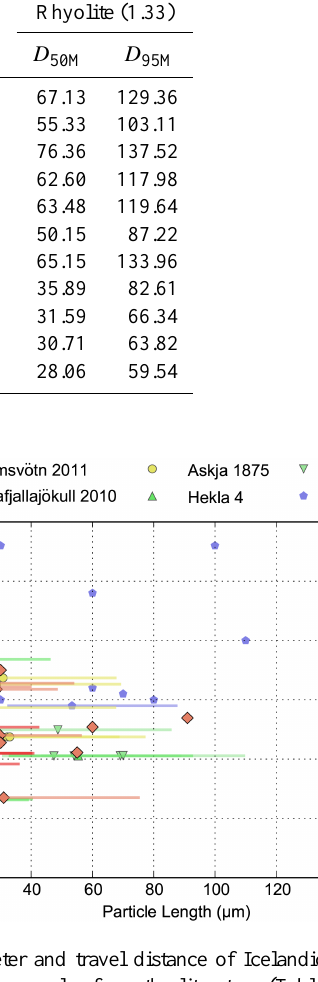
Table 3. Estimated grain-size mass distribution parameters for distal cryptotephra using data from Table 2 and extreme examples of ratios of particle length to particle spherical equivalent diameter from Riley et al. (2003). D 50M is the median mass diameter (µm); 95% of the mass is within particles with diameters less than D 95M (µm). Eruption Location Basalt (1.05)